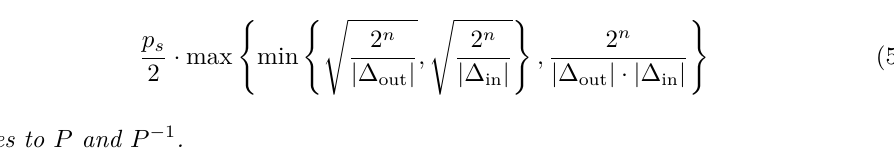
Figure 8: The game G A that defines the limited birthday problem on a random permutation P . The lists L X , L Y , and L P are set to be empty at the beginning of the game. p s ≤ 1 / 2 ), A has to make at